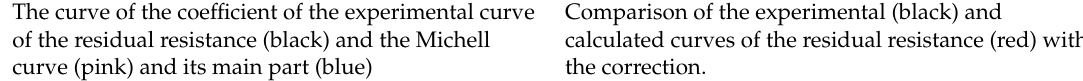
the main part of Michell’s integral (blue line).